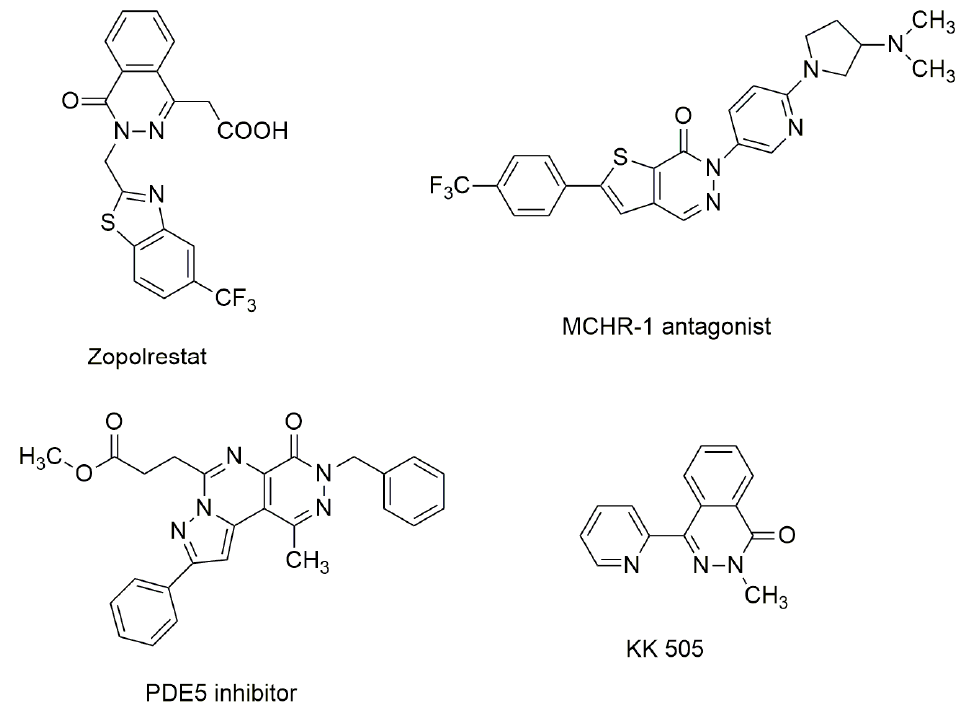
Figure 4. Biologically active